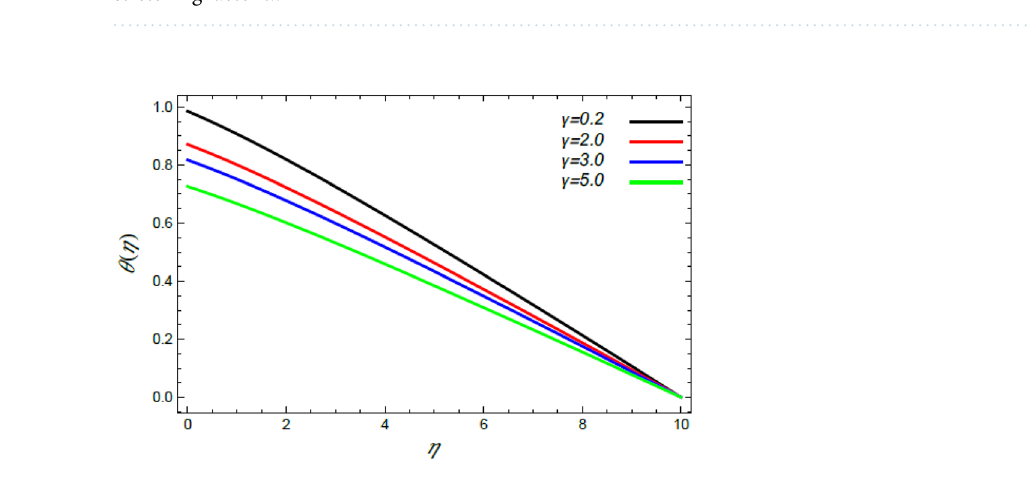
Figure 17. Deviation of the heat profile θ(η) versus η as given in Eq. (66) to illustrate the impact of the thermal slip factor γ